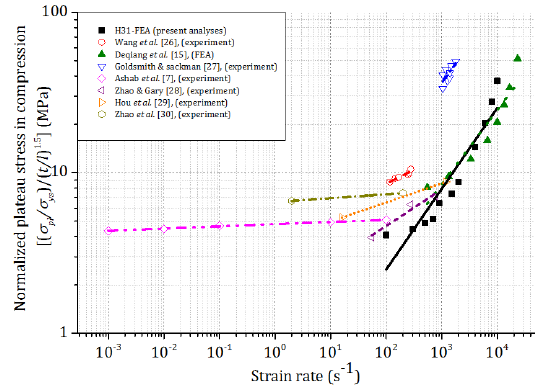
Figure 9. Normalized plateau stress of honeycomb vs. strain rate of honeycombs in compression.